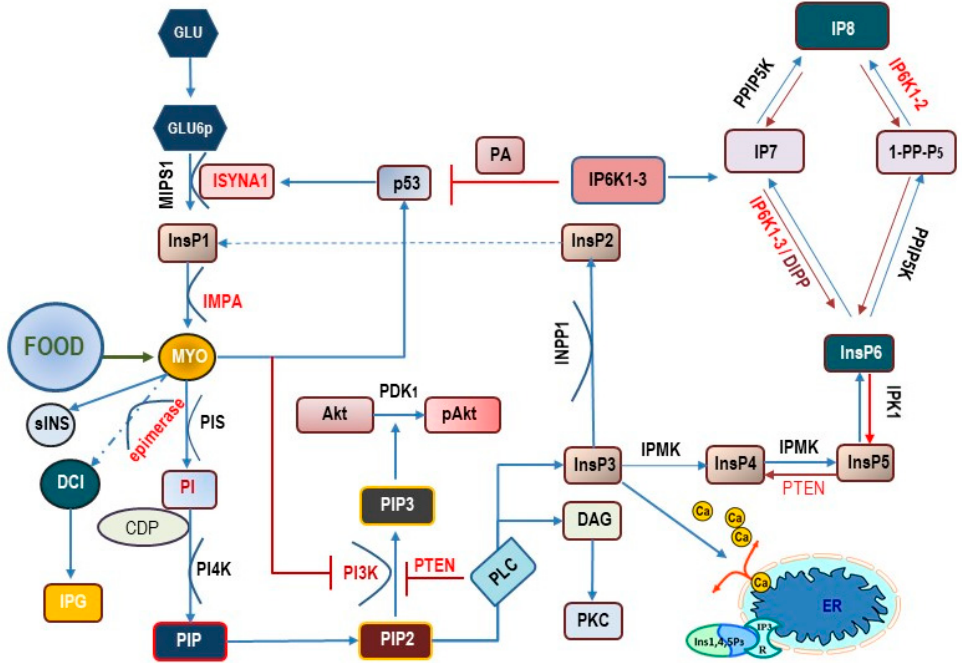
Figure 1. Main metabolic pathways related to myo-inositol transformation inside the cell. Myo-Ins is obtained from external sources (food) and produced by a biosynthetic pathway departing from glucose (Glu) and glucose-6-phosphate (Glu6p). Under the catalytic activity of myo-inositol-1-phosphate synthase 1 (MIPS1)—encoded by the ISYNA1 gene—Glu6p is converted into inositol-1-phosphate (InsP1) and then dephosphorylated to myo-Ins under the action of inositol monophosphatase-1